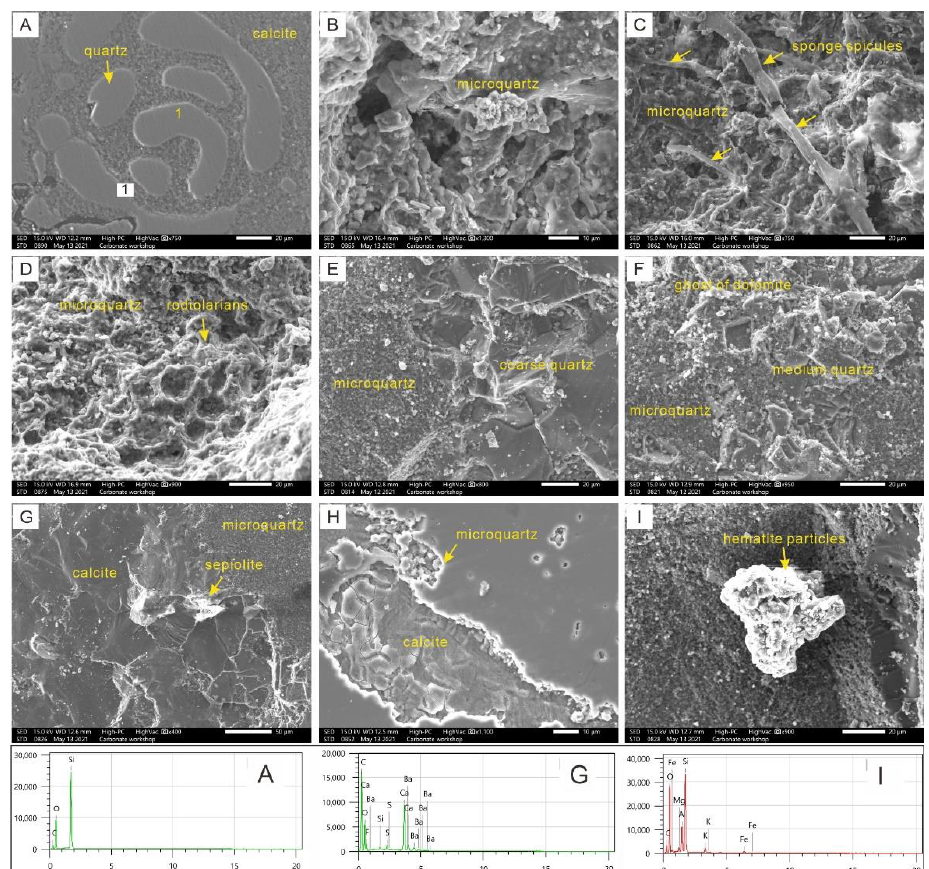
Figure 5. SEM photographs of studied Maokou cherts and host limestones. ( A ) Bioclasts were silicified into quartz in the host limestone, MEY section; ( B ) bedded chert composed of microquartz, EY section; ( C ) abundant sponge spicules (yellow arrows) in bedded chert, SH section; ( D ) radiolarians in bedded chert occurred as microquartz, LSX section; ( E ) silica recrystallization to medium crystalline quartz close to the microquartz, MEY section; ( F ) ghost dolomite in nodular chert, MEY section; ( G ) sepiolite occurs within intergranular pores of a calcitic nodular chert, MEY section; ( H ) calcite filled a microfracture in nodular chert, MEY section; ( I ) hematite in the nodular chert, MEY section.